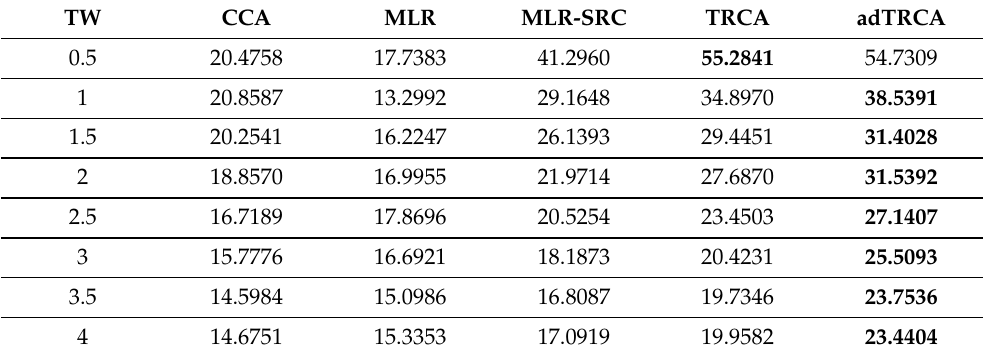
Table 5. ITR on EPOC dataset—2 channels.